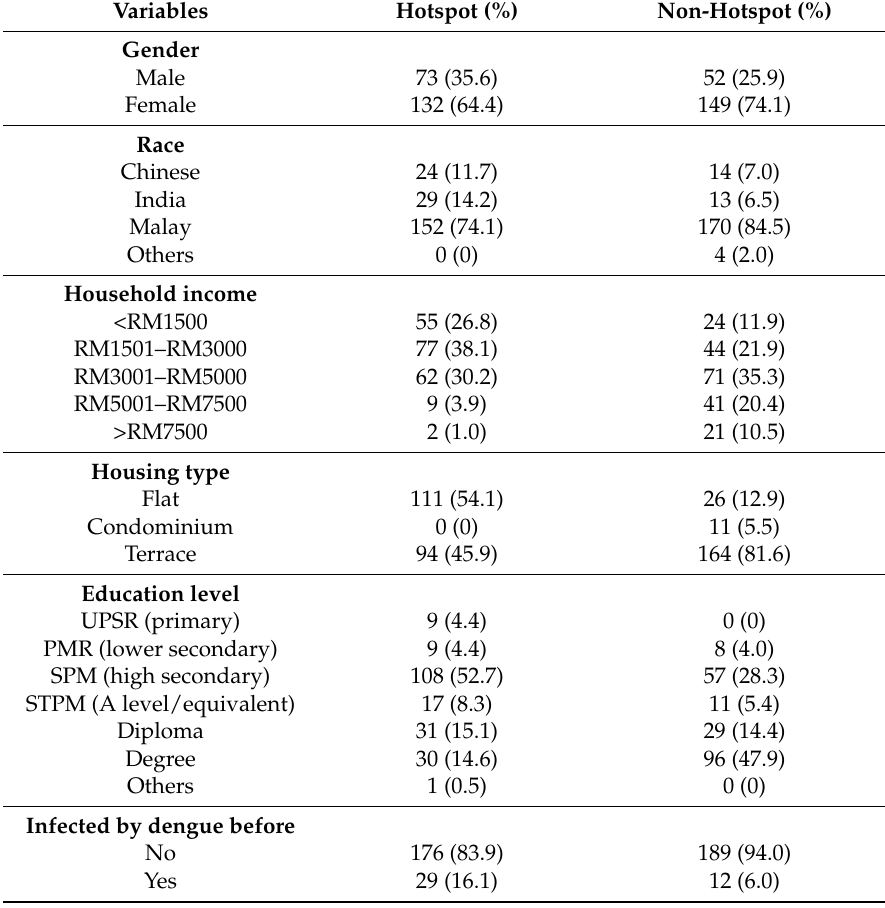
Table 1. Demographic